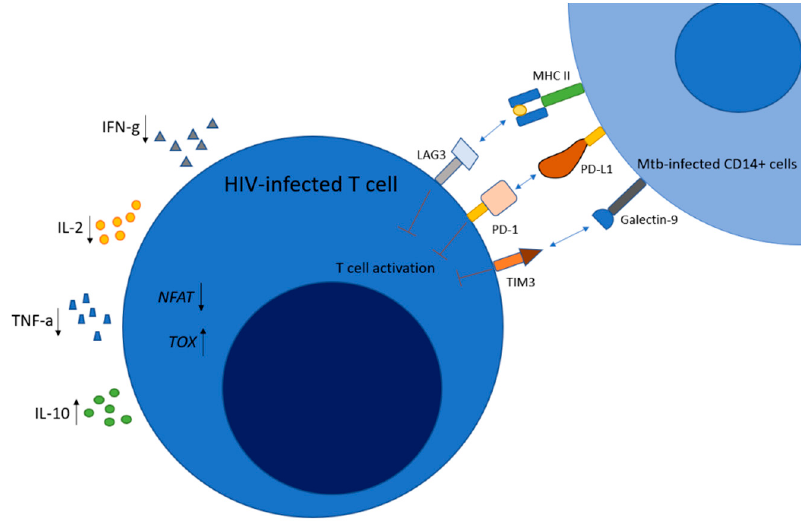
Figure 3. Mtb-infected CD14 + cells mediate T cell exhaustion. Ligands from Mtb -infected CD14 + cells inhibit T cell activation, thereby decreasing intracellular nuclear factor of T cell activation (NFAT), but increasing TOX proteins and inflammatory cytokines. IFN- γ and IL-2 secretion decrease, while the secretion of the immunosuppressive cytokine, IL-10, increases.